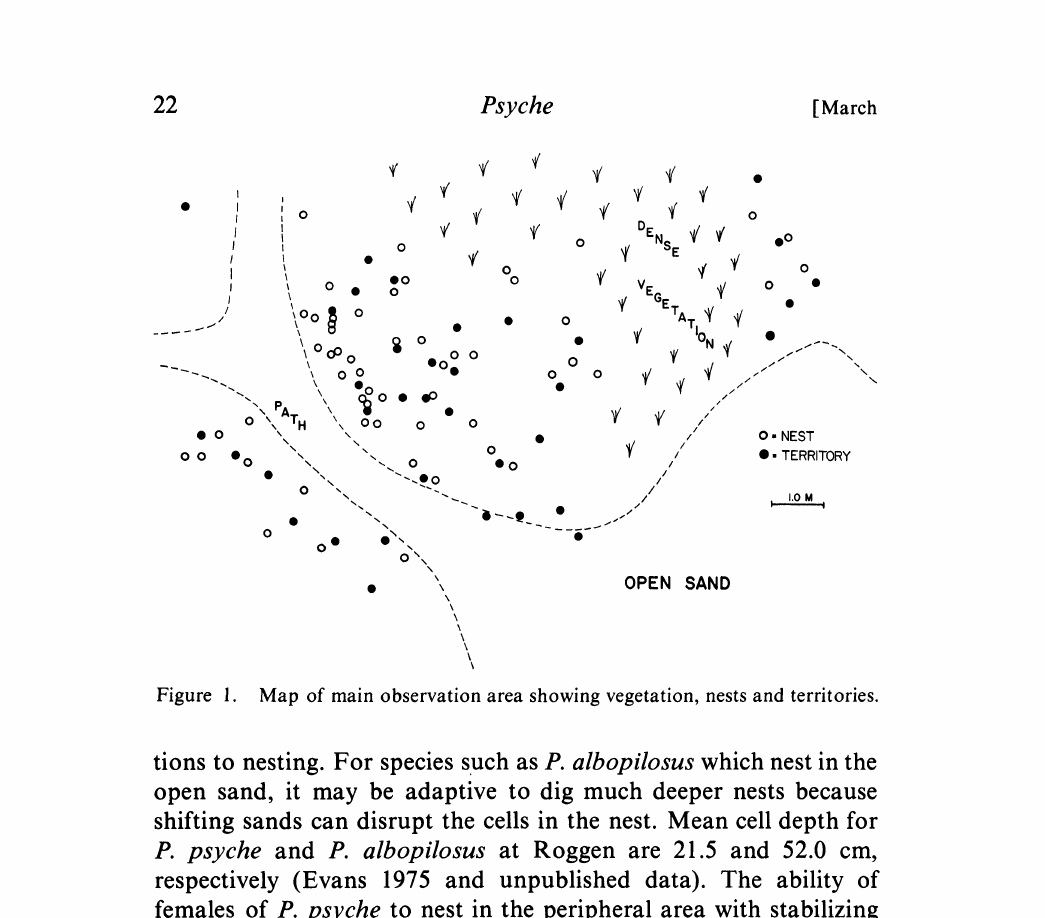
Figure 1. Map of main observation area showing vegetation, nests and territories. tions to nesting. For species such as P. albopilosus which nest in the open sand, it may be adaptive to dig much deeper nests because shifting sands can disrupt the cells in the nest. Mean cell depth for P. psyche and P. albopilosus at Roggen are 21.5 and 52.0 cm, respectively (Evans 1975 and unpublished data). The ability of females of P. psyche to nest in the peripheral area with stabilizing vegetation allows them to dig shallower nests and possibly more per season and to avoid the high surface temperatures of the open sand during the middle of the